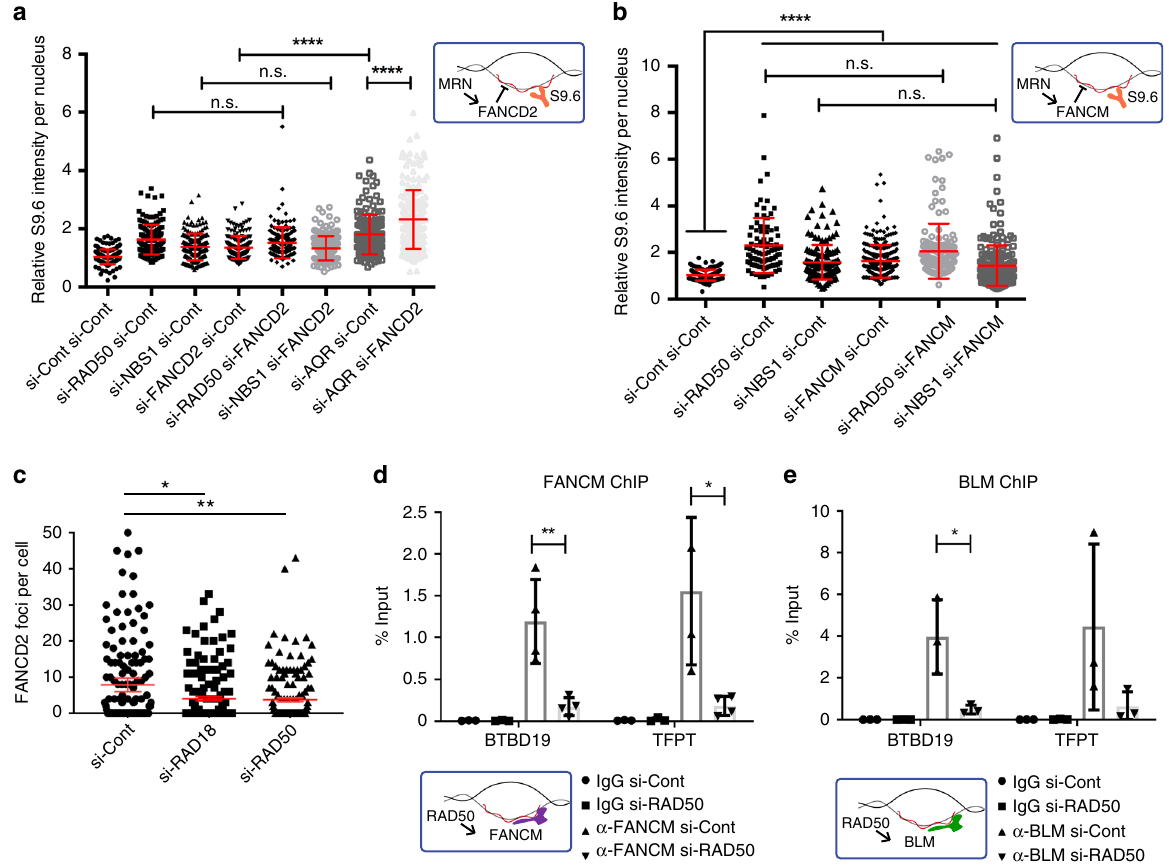
Fig. 6 MRN functions in the Fanconi Anemia pathway to recruit FA proteins to R-loops. a and b Epistatic effects on nuclear S9.6-staining intensity in the indicated conditions. Aquarius (AQR) is a splicing helicase and R-loop regulator in a different pathway, and AQR depletion showed additive nuclear S9.6 staining increases with si-FANCD2 in a . N = 3; **** P < 0.0001 by ANOVA; mean ± SD. c Quanti fi cation of nuclear FANCD2 foci by immuno fl uorescence in the indicated cell conditions. Three replicate experiments were performed and the aggregate foci counts were compared by Fisher Exact test and Bonferroni corrected p value cutoffs were used. * P < 0.05 and ** P < 0.01. d and e ChIP of FANCM and BLM at R-loop prone loci BTBD and TFPT depends on RAD50. N = 3; * P < 0.05 and ** P < 0.01 by t test; mean ± SEM. Cartoons illustrating the MRN-FA pathway a , b and the positive effects